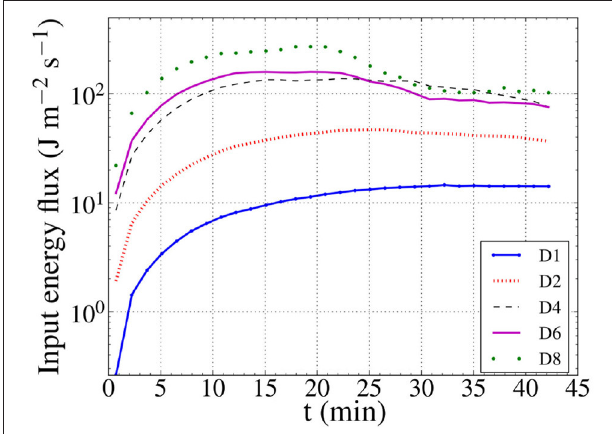
FIGURE 5 | Evolution of the average values of the energy fluxes provided by the driver of each model (in W m − 2 ) over time.